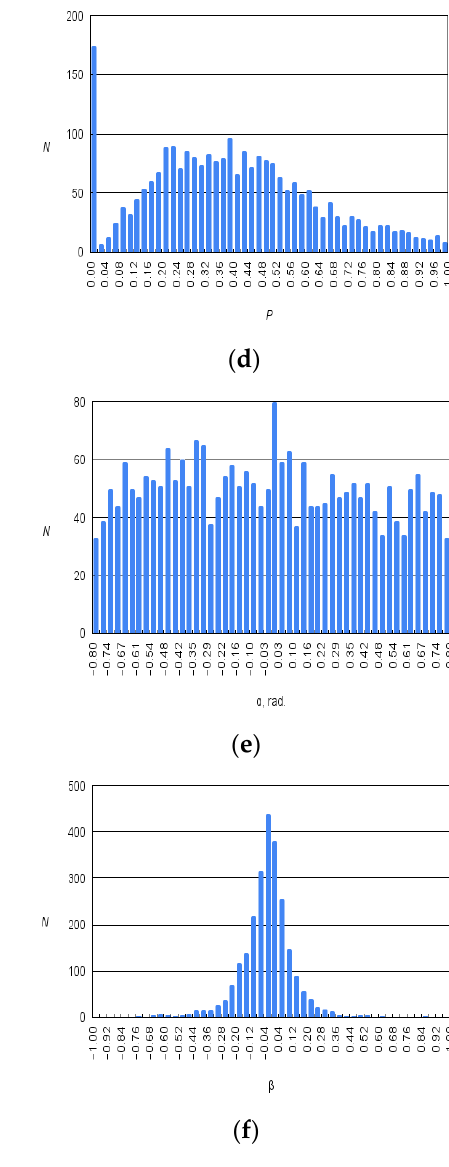
Figure 2. Coordinate distributions of the parameters of the Stokes vector 𝑆 1 (𝐚) , 𝑆 2 (𝐛) , 𝑆 3 (𝐜) , and their corresponding histograms ( d – f ) of the object under investigation.